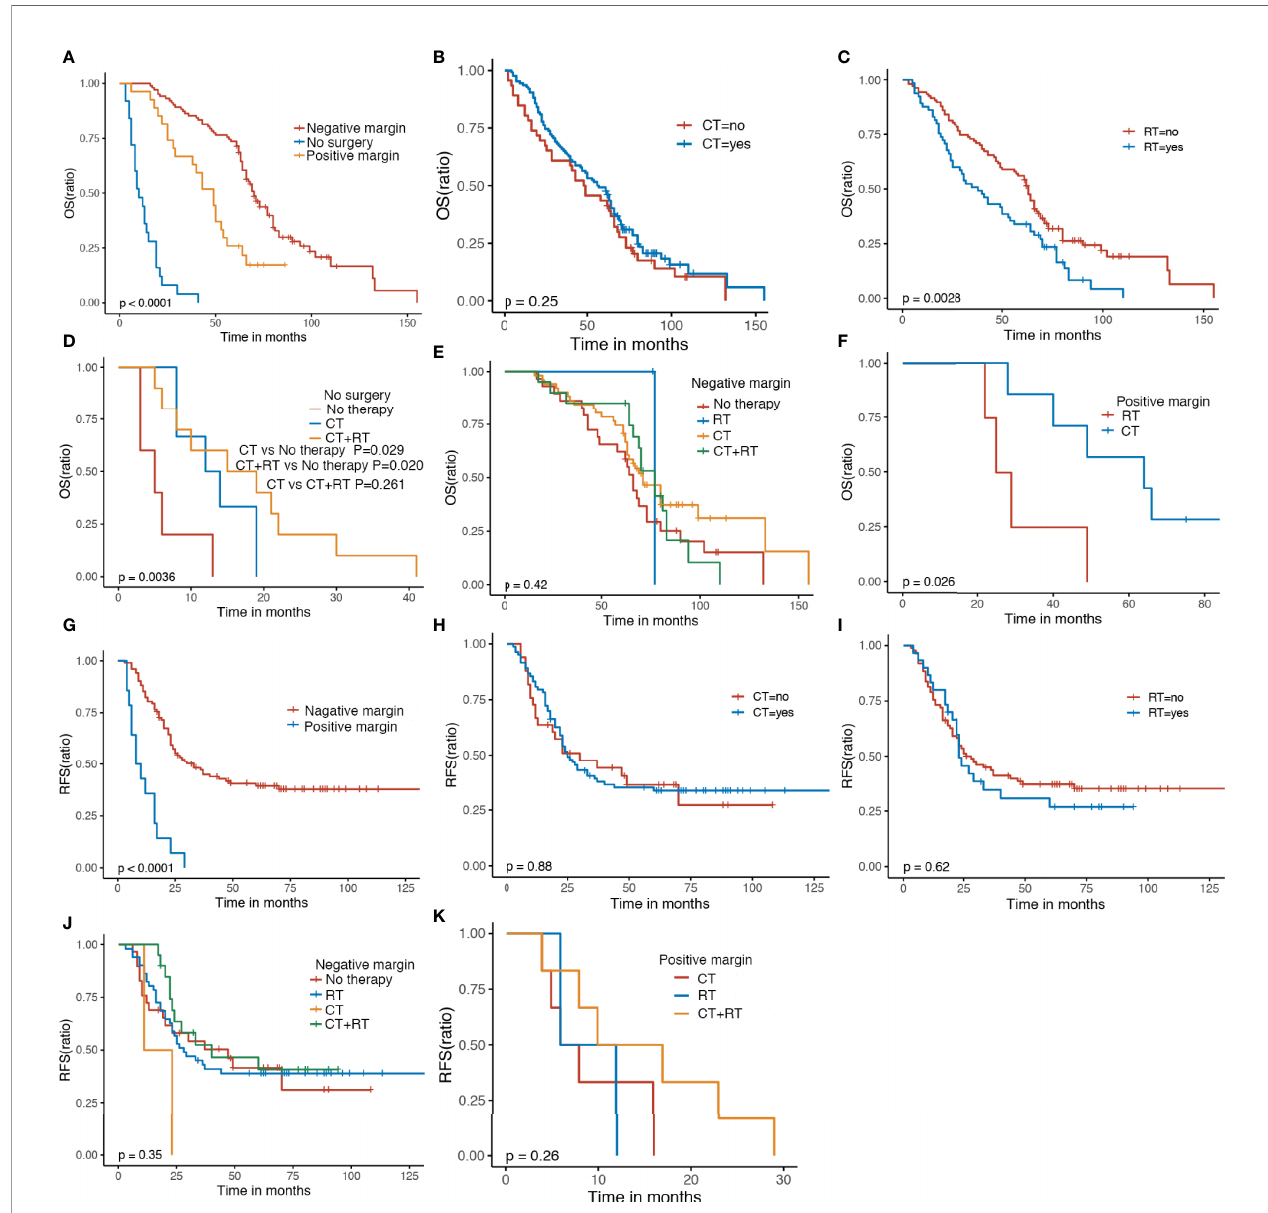
FIGURE 3 | The Kaplan – Meier OS and RFS of GS patients with regard to surgery status (A, G) , CT (B, H) and RT (C, I) . Kaplan – Meier survival estimates of OS and RFS in GS patients with no surgery (D) , negative margin (E, J) and positive margin (F, K) strati fi ed by adjuvant therapy. OS, overall survival; RFS, recurrence-free survival; CT, chemotherapy; RT,